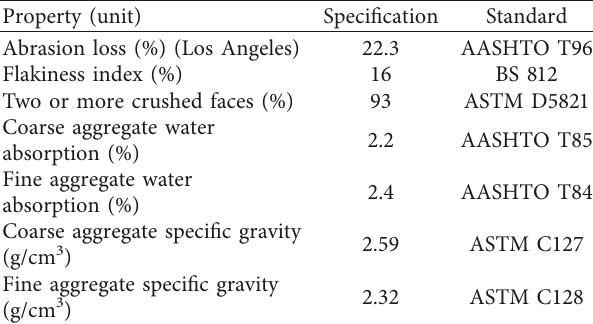
Table 3: Aggregate